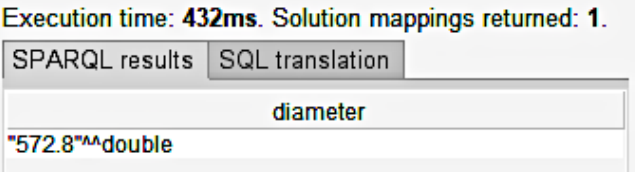
Figure 7. SPARQL result from Listing